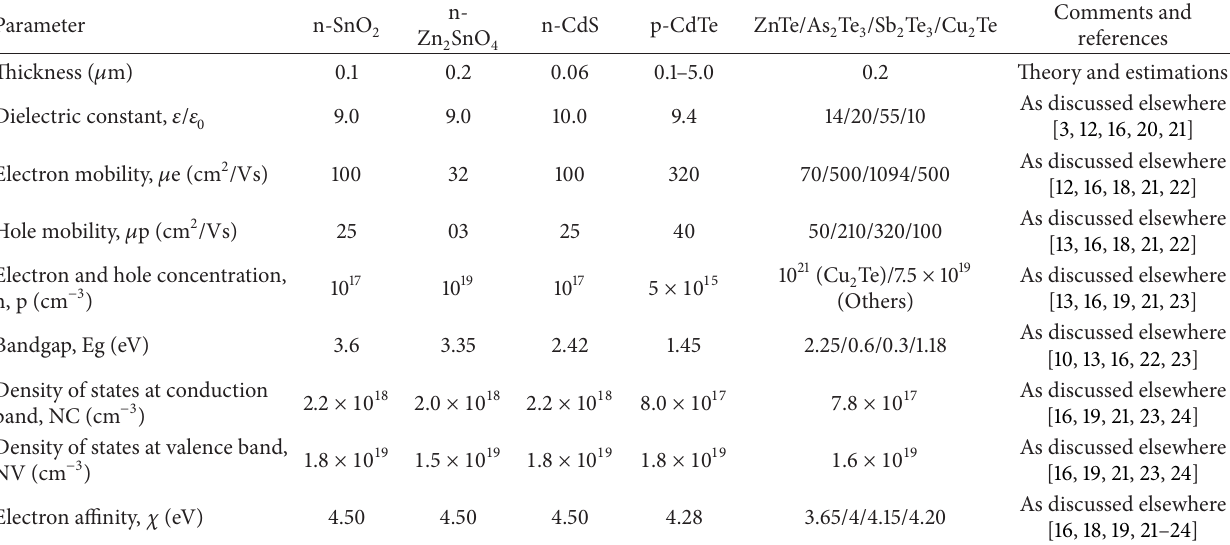
Figure 1: Structures of the CdTe solar cells: (a) reference structure, (b) proposed structure for higher performance. Table 1: Material parameters used in